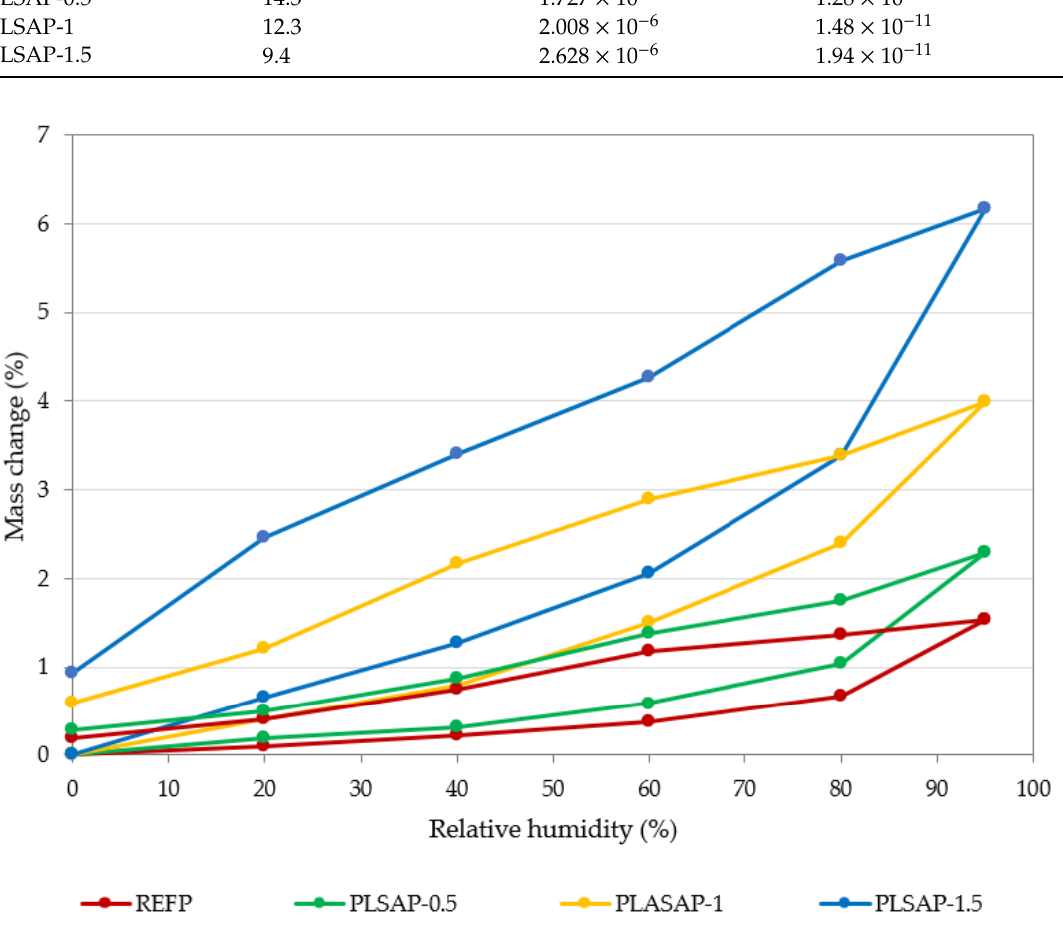
Figure 3. Sorption and desorption isotherms of studied plasters.